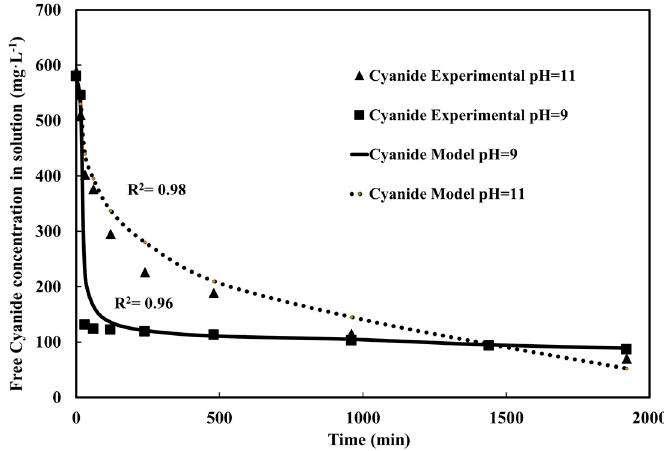
Figure 10. Prediction vs. measurement of cyanide concentrations in solution for the gold + pyrite + chalcopyrite system at pH = 9 and 11.